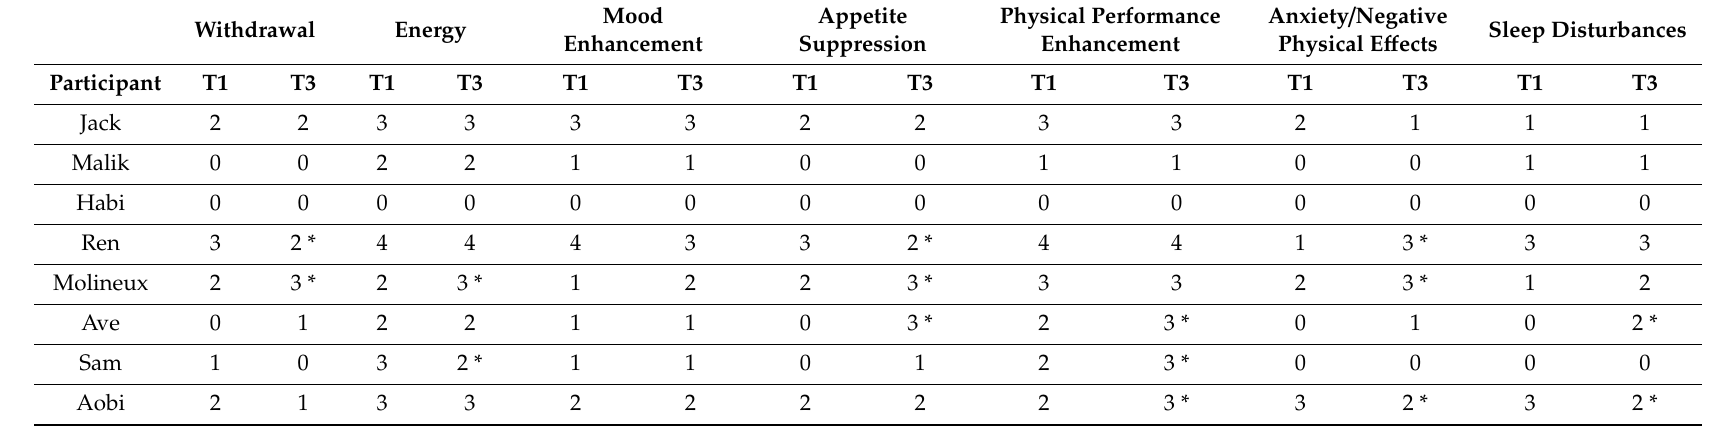
Table 4. Subjective Ca ff EQ scores across trials 1 and 3, alteration in expectancy type denoted by *. (i.e., 1 = unlikely, 2 = a little unlikely, 3 = a little likely, 4 = likely, 5 = very likely). T1 and T3 = trials 1 and